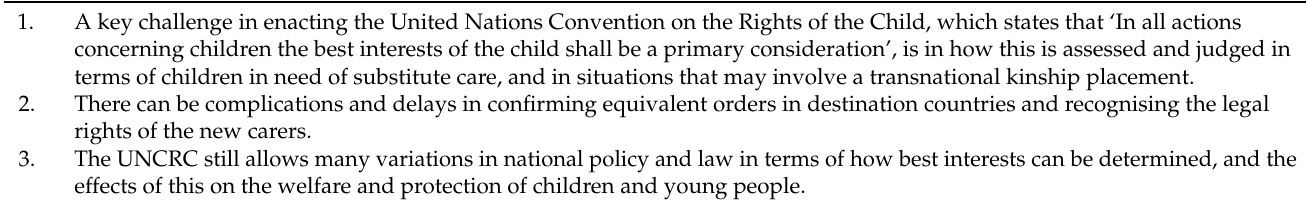
Table 3. Judicial and policy challenges across different